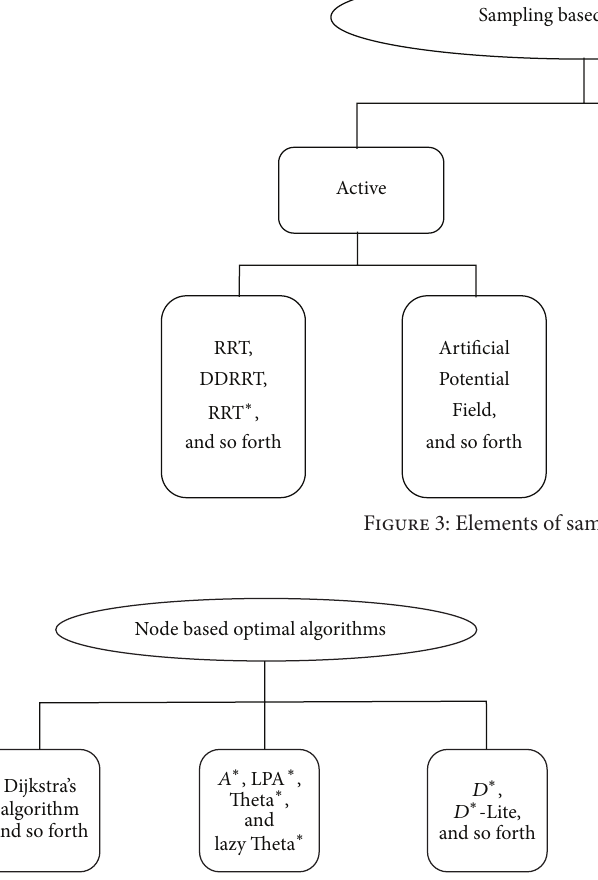
Figure 4: Elements of node based